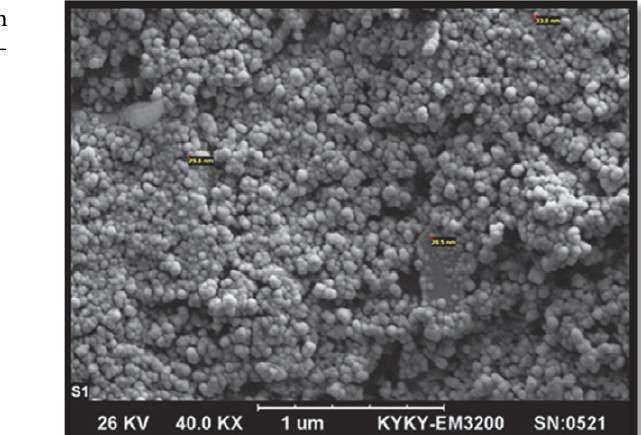
Figure 4. SEM image of MnFe 2 O 4